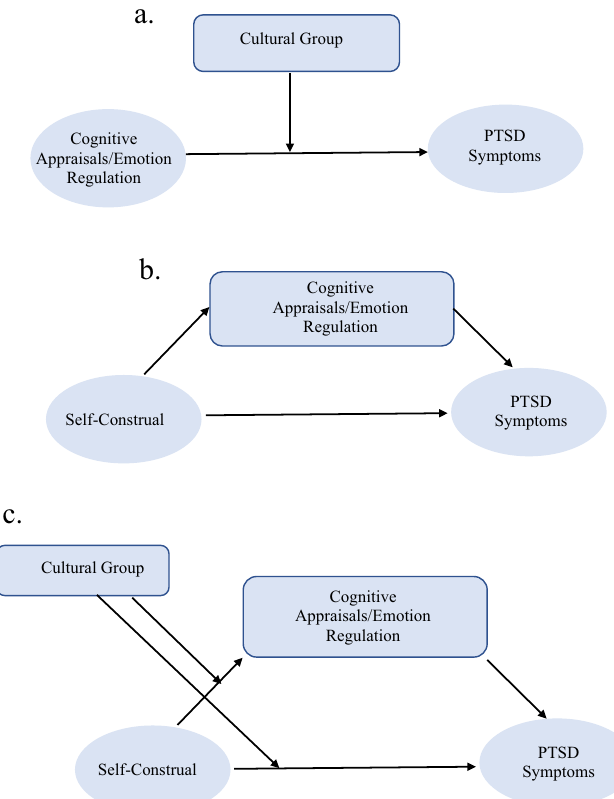
Figure 1. Figure depicting the moderation analyses ( a ), mediation analyses ( b ) and moderated mediation analyses ( c